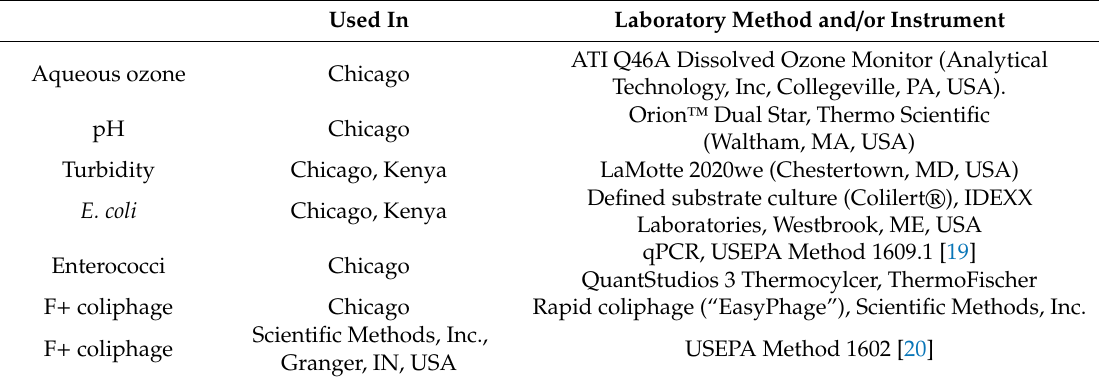
Figure 1. Schematic diagram of the point-of-use ozonation (POU-O 3 ) system as deployed in Kenya. At the University of Illinois at Chicago (UIC), the system was operated using 110 V alternating current, rather than direct current from a solar panel. Table 1. Water analysis methods and instruments .